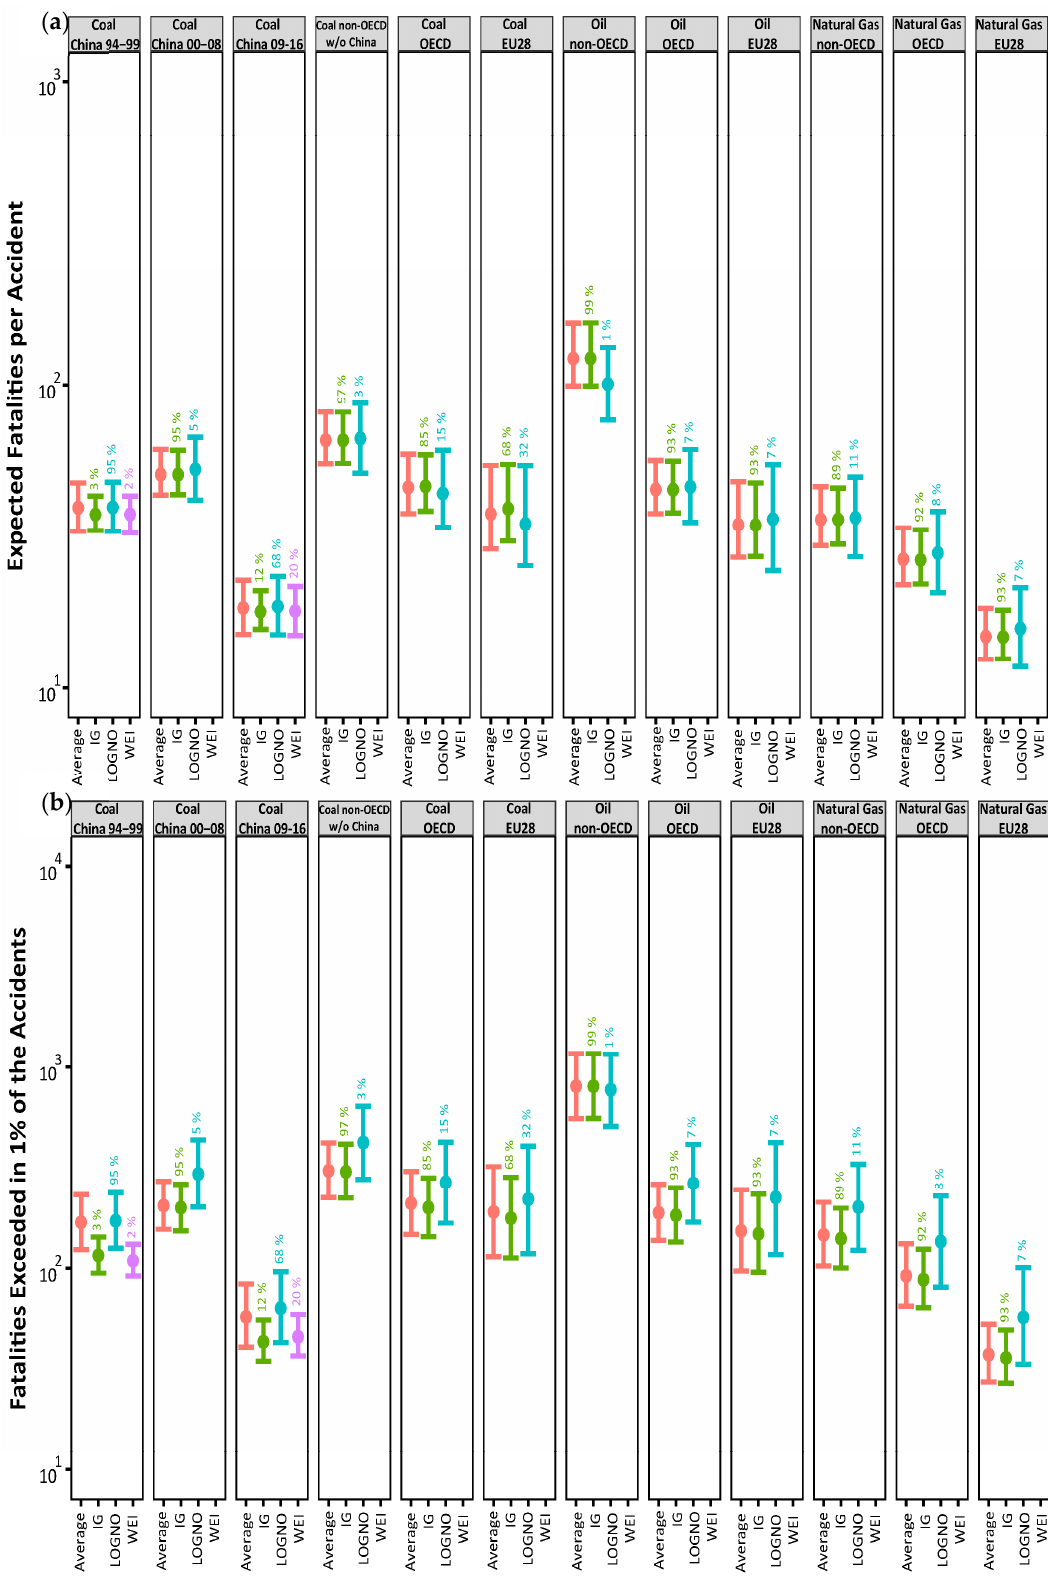
Figure 2. For each energy chain and country group combination, expected fatalities per accident are shown for the selected set of distributions as well as the BMA (Average), including mean, 5% and 95% quantiles and percent contributions (weights). ( a ) Expected fatalities in log scale. ( b ) Fatalities exceeded in 1% of all accidents in log scale.